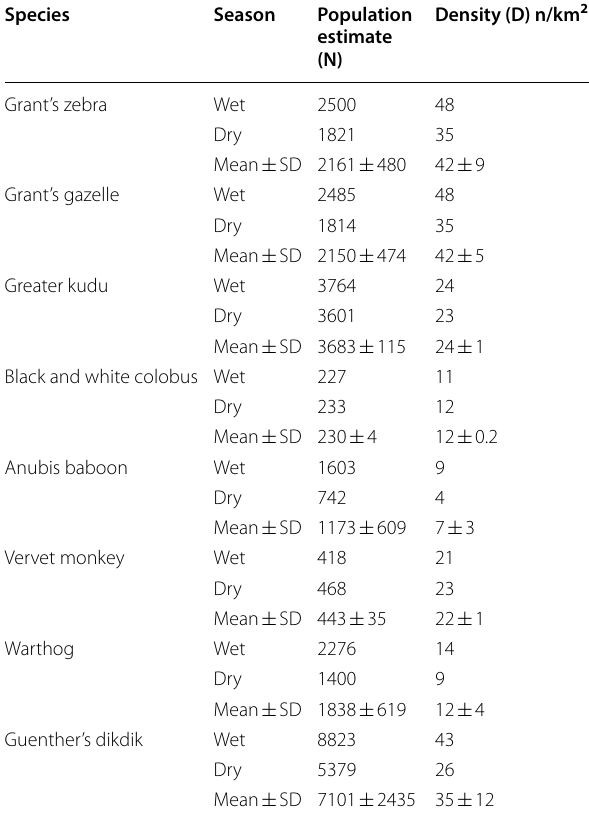
Table 4 Population estimate of selected terrestrial large mammals in the NSNP (mean